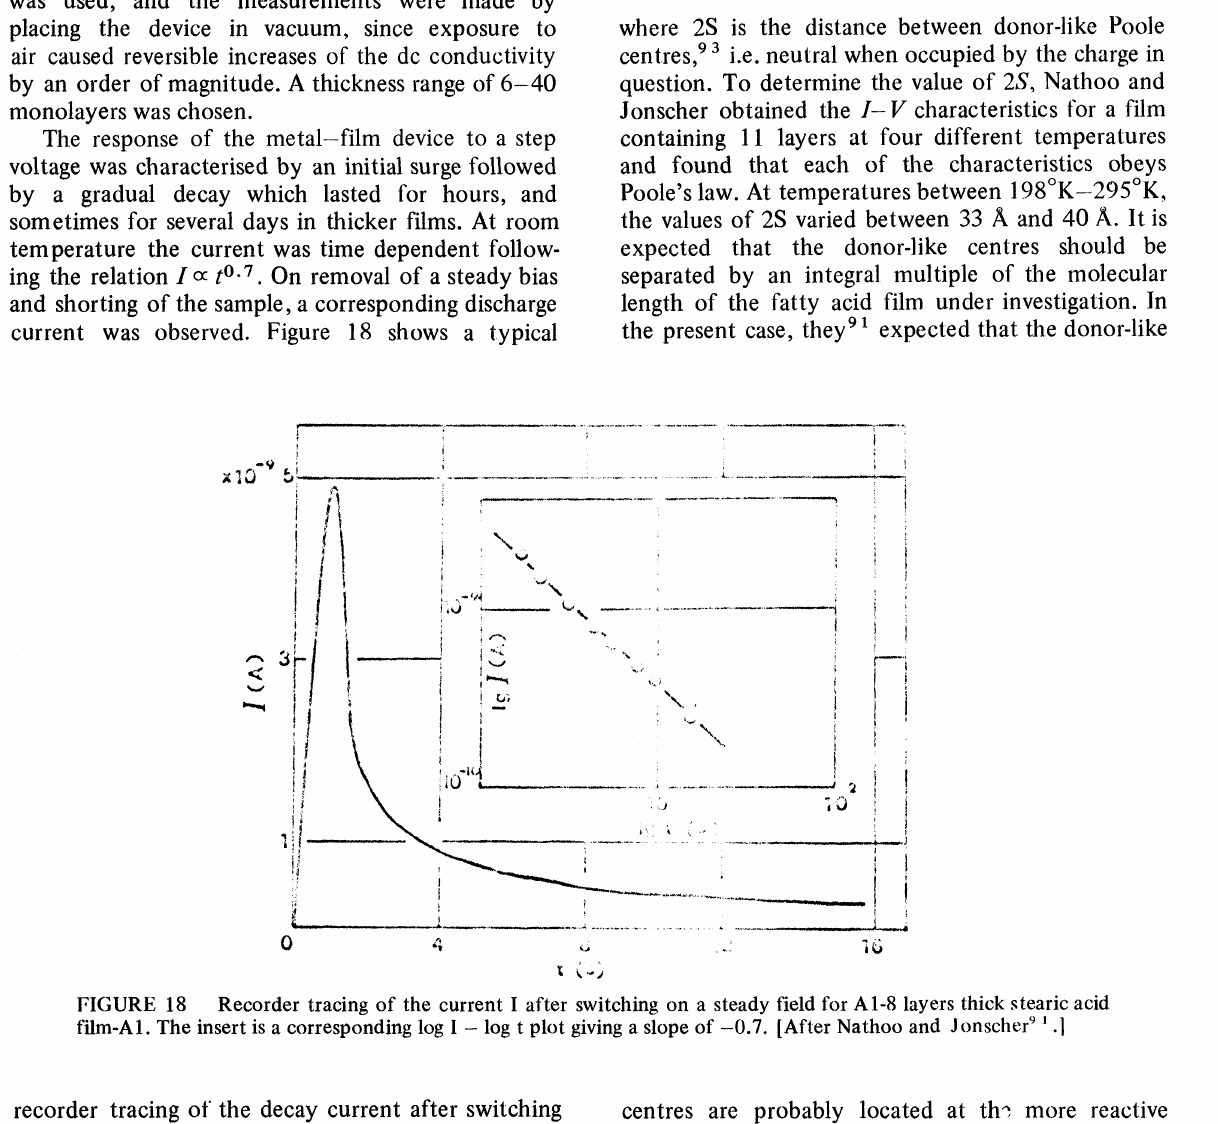
FIGURE 18 Recorder tracing of the current after switching on a steady field for A1-8 layers thick stearic acid film-A1. The insert is a corresponding log log plot giving a slope of -0.7. [After Nathoo and Jonscher